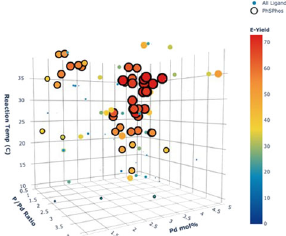
Fig. 7 Three-dimensional plot of three continuous parameter selections color coded for 2- E yield in campaign 2. PhSPhos results are outlined; all other ligand results are not